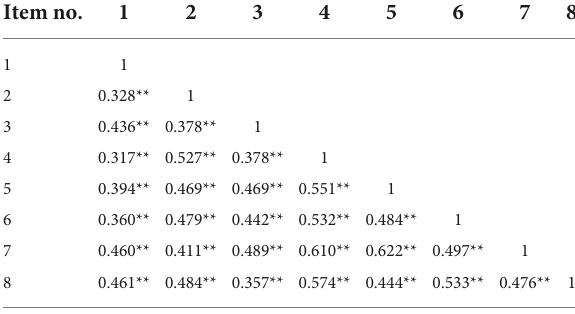
TABLE 1 Stress Mindset Measure inter-item correlations. Item